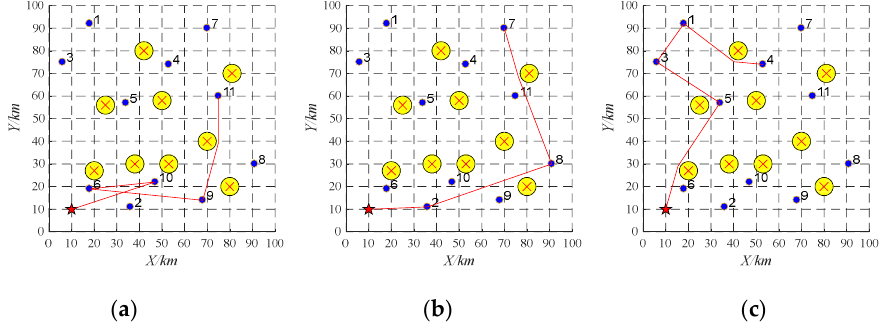
Figure 8. Task re-scheduling schemes with the emergency task based on buy-sell contract. ( a ) UAV-01;